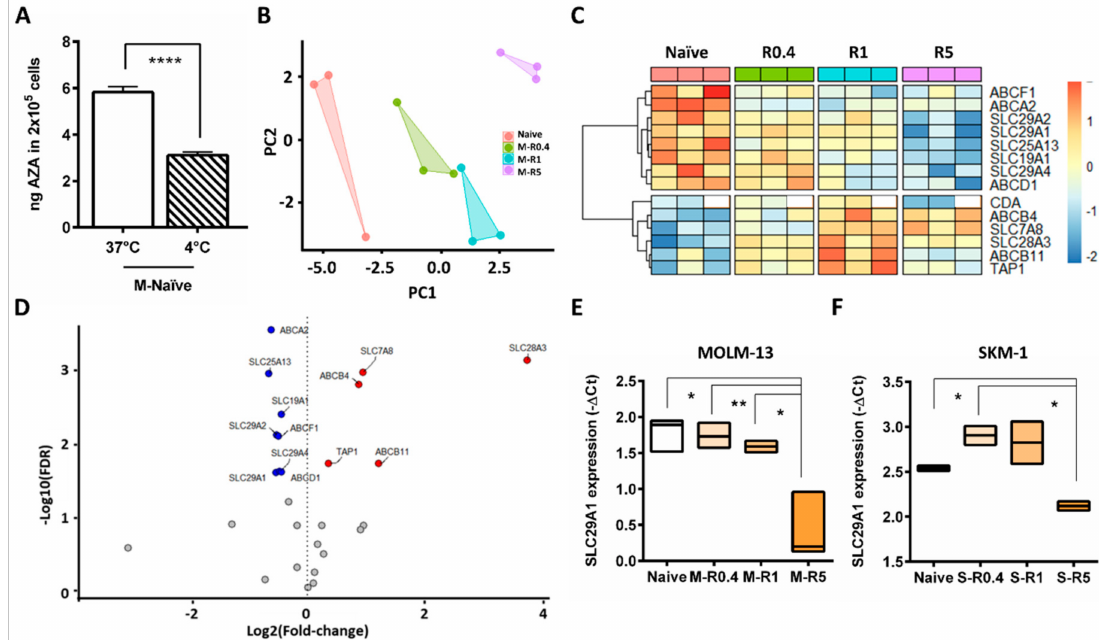
Figure 2. Differential expression of transporter genes in MOLM-13 AZA-resistant compared to parental cells. ( A ) In MOLM-13-naïve cells 14 C-AZA IUR was significantly lower at 4 ◦ C compared to 37 ◦ C suggesting temperature dependent active cellular transport. ( B ) Principal component analysis (PCA) showed that intermediate resistant cells (M-R0.4 and M-R1), highly resistant cells (M-R5), and naïve cells exhibit distinct gene expression profile. ( C ) Heatmap of the cellular transporter and metabolism genes differentially expressed in naïve and resistant MOLM-13 cells. White color boxes in CDA indicate lack of data. ( D ) Volcano plot demonstrating differential gene expression between resistant and naïve MOLM-13 cells. X -axis show the effect of log2 fold change while log10-adjusted p value (FDR) is shown on the y -axis. Red circles indicate increased gene expression in AZA-resistant cells compared to naïve (FDR adjusted p < 0.05 and log2 fold change >0), while blue circles indicate genes downregulated in AZA-resistant compared to naïve cells (FDR adjusted p < 0.05 and log2 fold change <0). Box plot representing SLC29A1 expression in ( E ) MOLM-13 and ( F ) SKM-1 cells. Student’s t -test was used to detect statistically significant differences between cohorts. Asterisks display p -values * p < 0.05, ** p < 0.01, **** p <